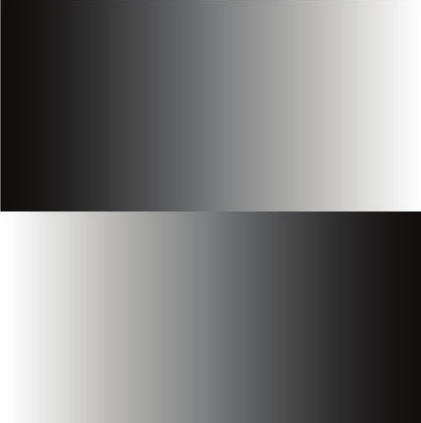
Figure 1: Two linear phase variations in equal and opposite directions in the upper and the lower regions of the wavefront.